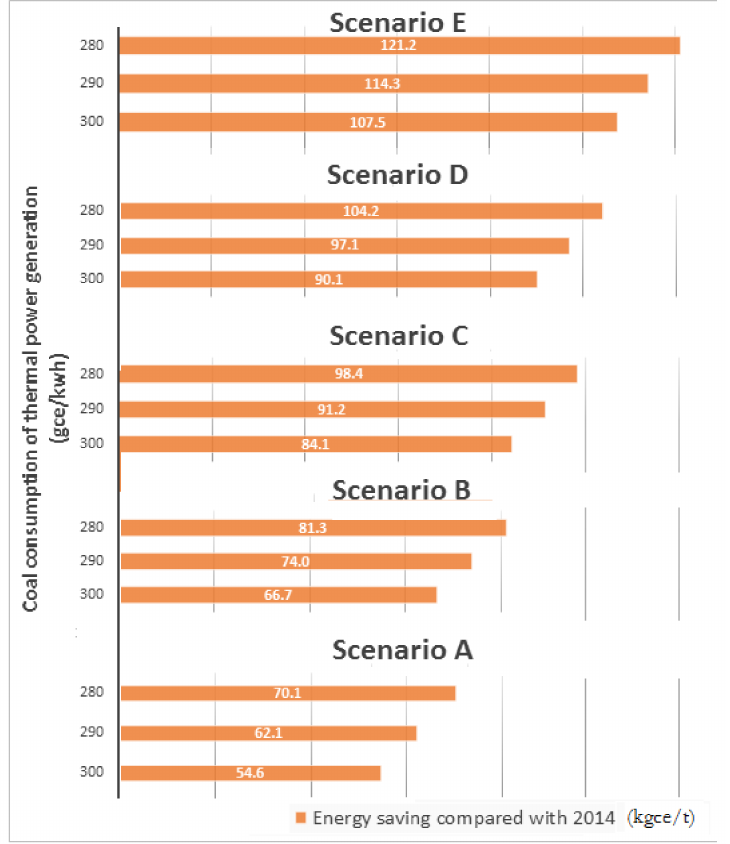
Figure 5. Energy saving potential of different power generation coal